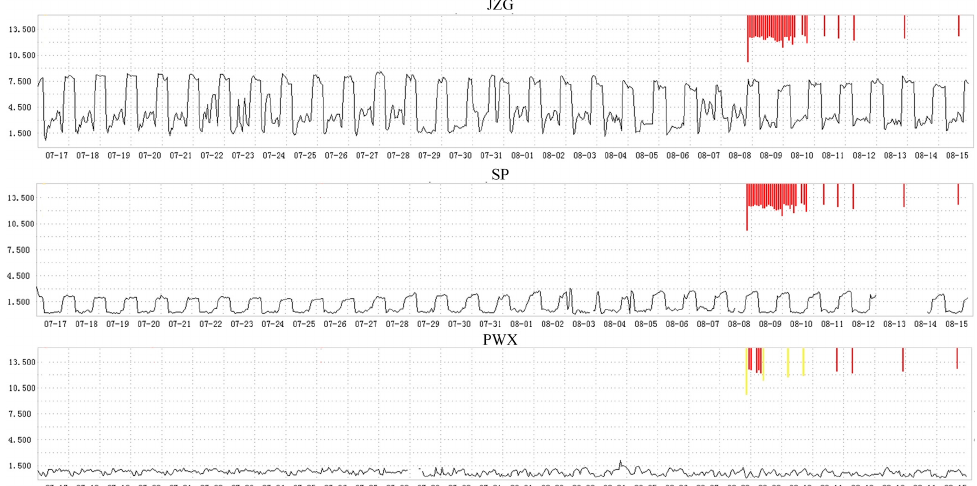
Figure 3. Electromagnetic signals from three stations near the Jiuzhaigou earthquake.